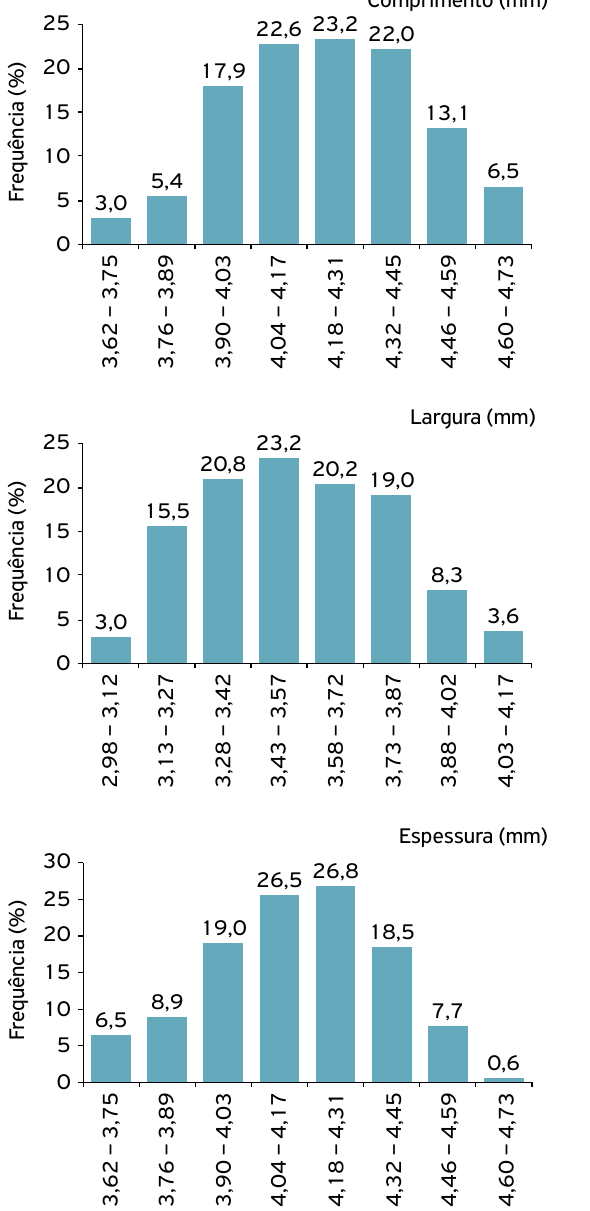
Figura 1. Histogramas das frequências do comprimento, largura e espessura (em mm) das sementes de Schinus terebinthifolius (n = 230).